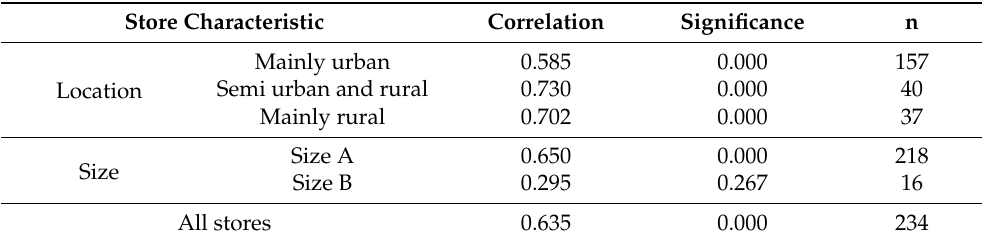
Table 4. Correlations between storage and delivery capacities by store characteristic. Store Characteristic